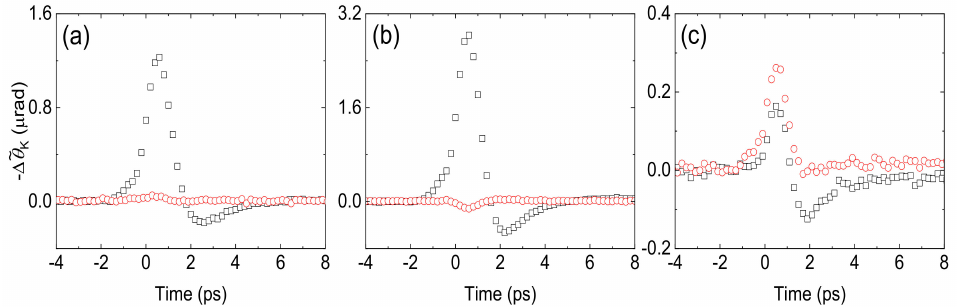
Figure 3. Detection of the spin accumulation on NM. The Kerr rotation due to the spin accumulation on NM with the probe on the cap side of the sap/Pt(10)/[Co/Ni](3.8)/Cu(100)/cap sample, where cap is ( a ) MgO(3), ( b ) Au(10), and ( c ) Pt(2). Black squares and red circles are the real and imaginary parts of the Kerr rotation,